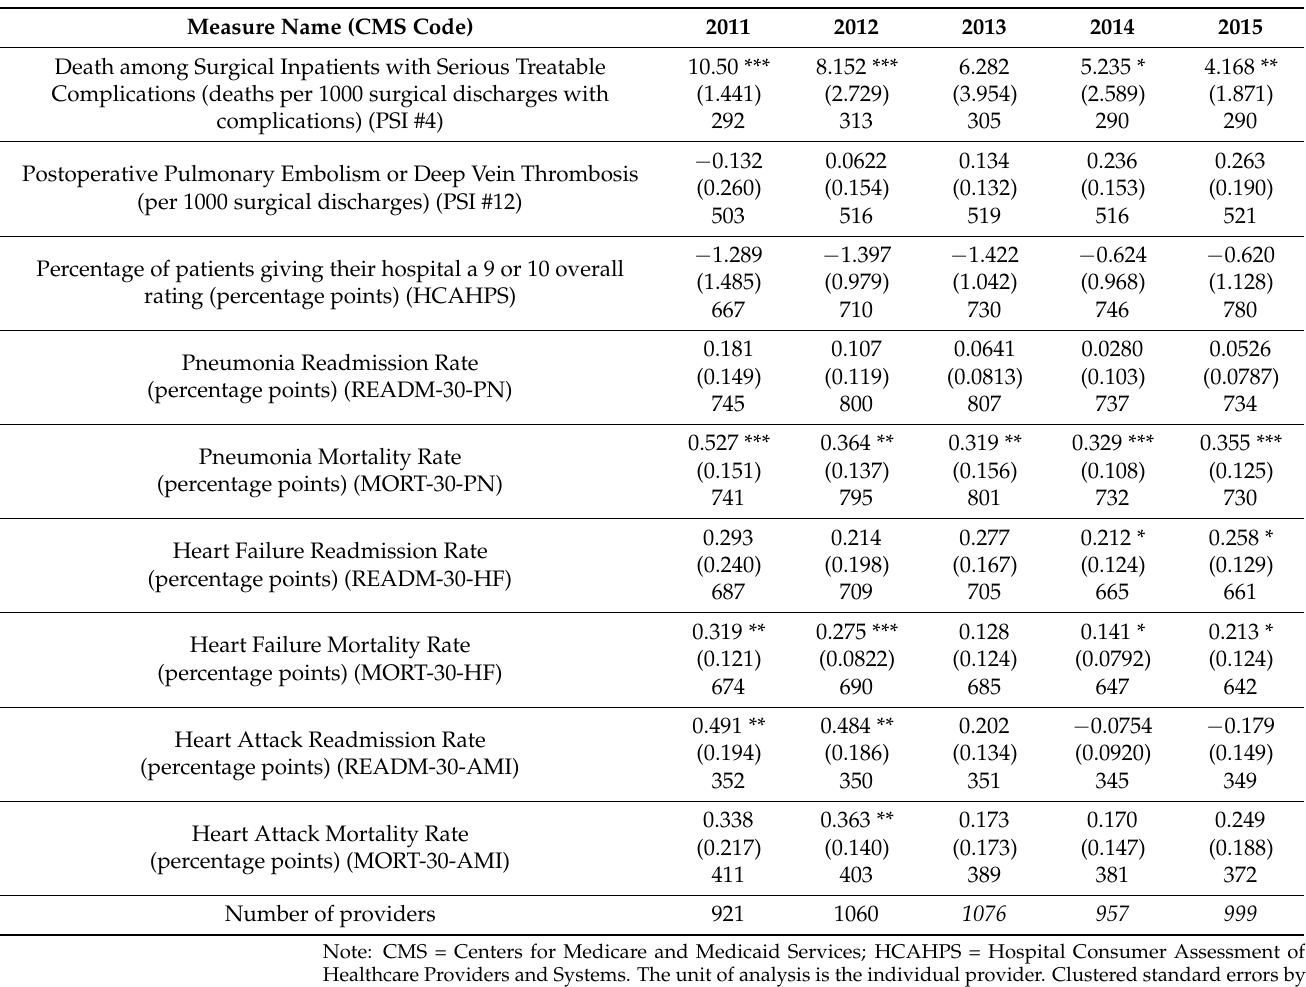
Table 9. Regression results by year